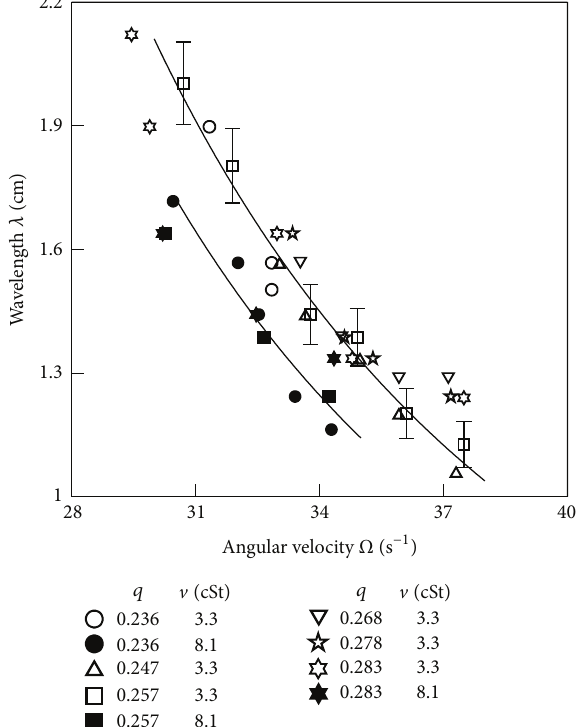
Figure 5: The wavelength of regular ripples versus angular velocity, 𝑚 = 250 g. The experimental data are obtained unless 𝑇 < 10 3 . The typical error bars are